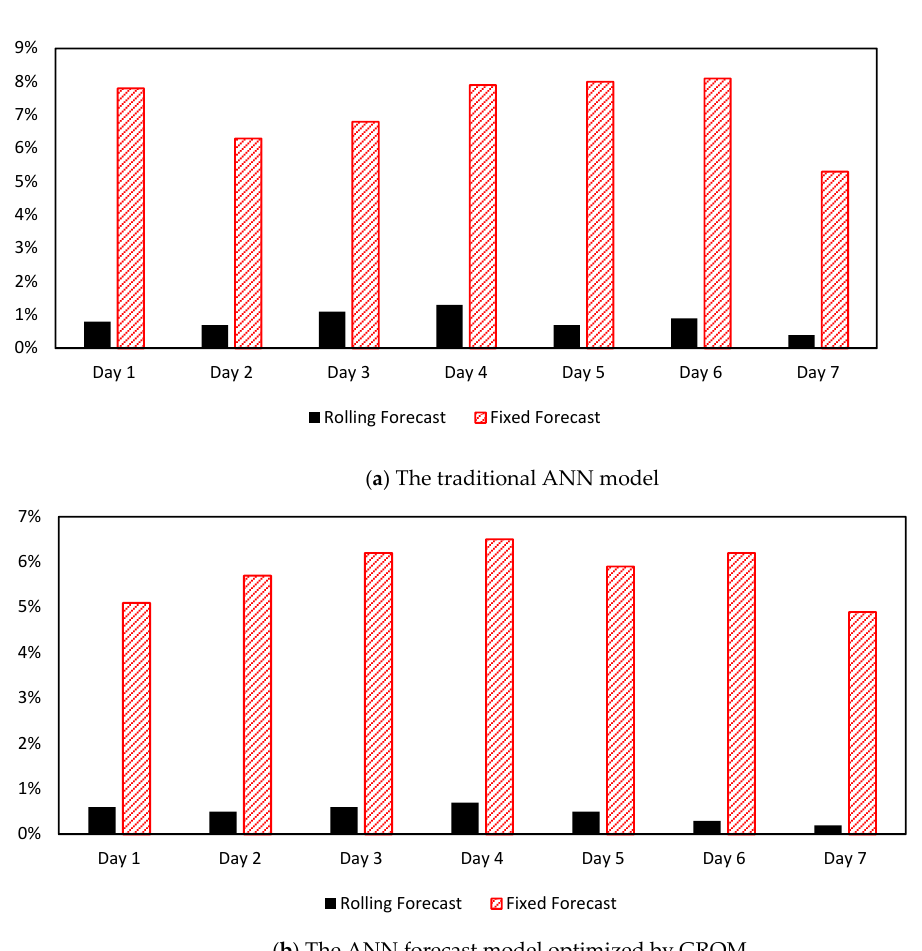
Figure 15. The daily MAPE scores for rolling and fixed forecasts models.